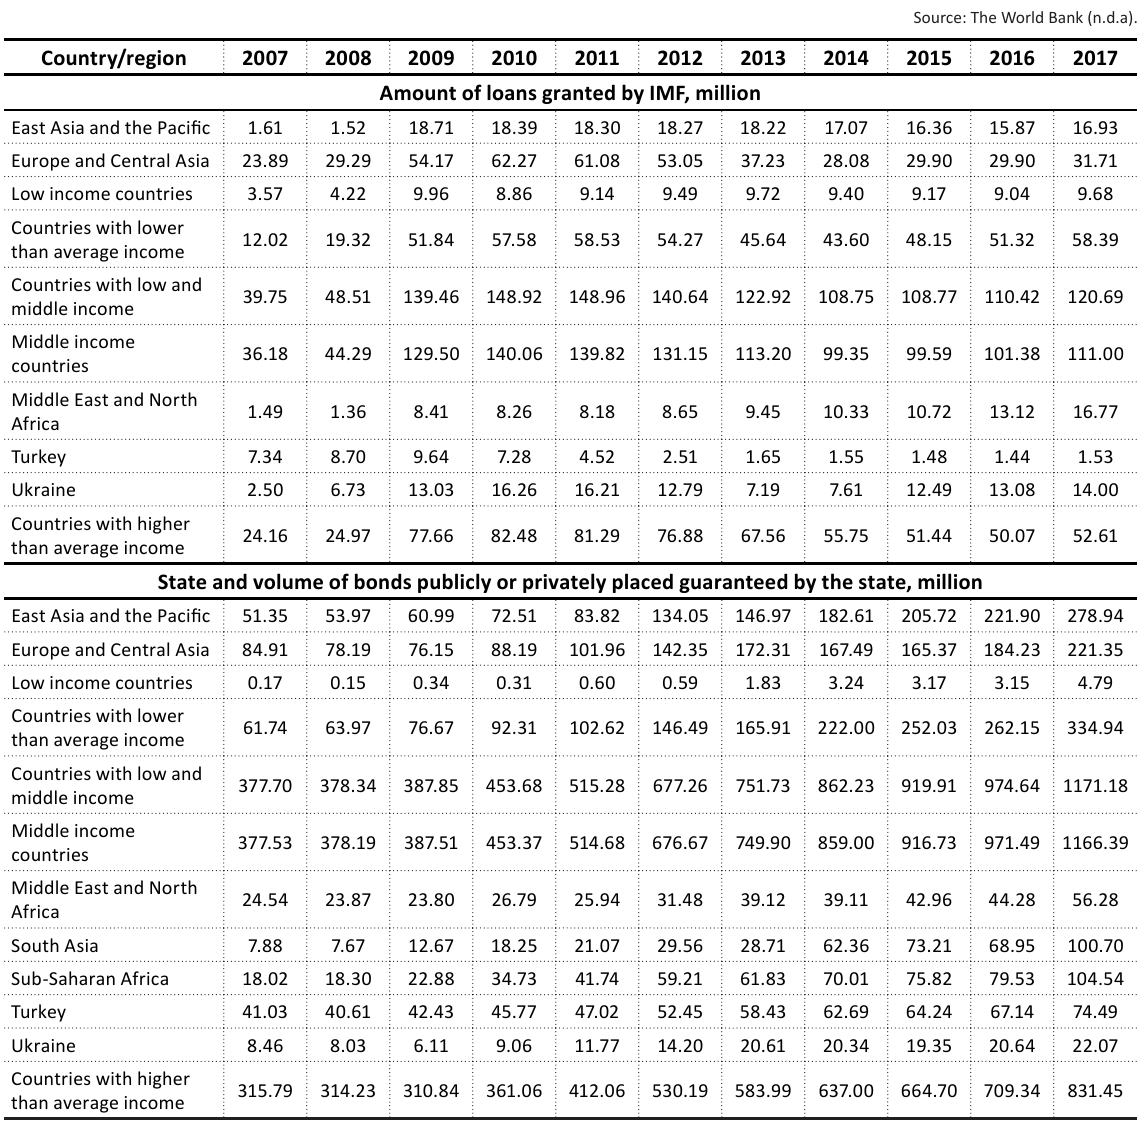
Table A1. Dynamics of external and internal loans in different countries / regions of the world in 2007–2017, million